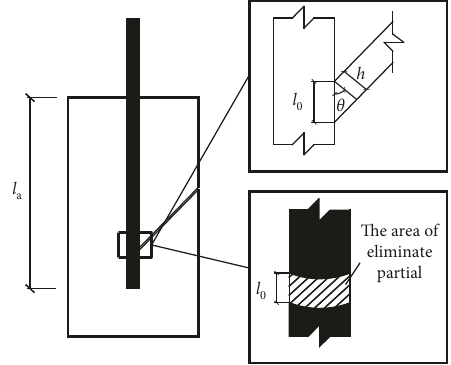
Figure 11: Schematic diagram of calculating Table 4: Test sequence and test results.